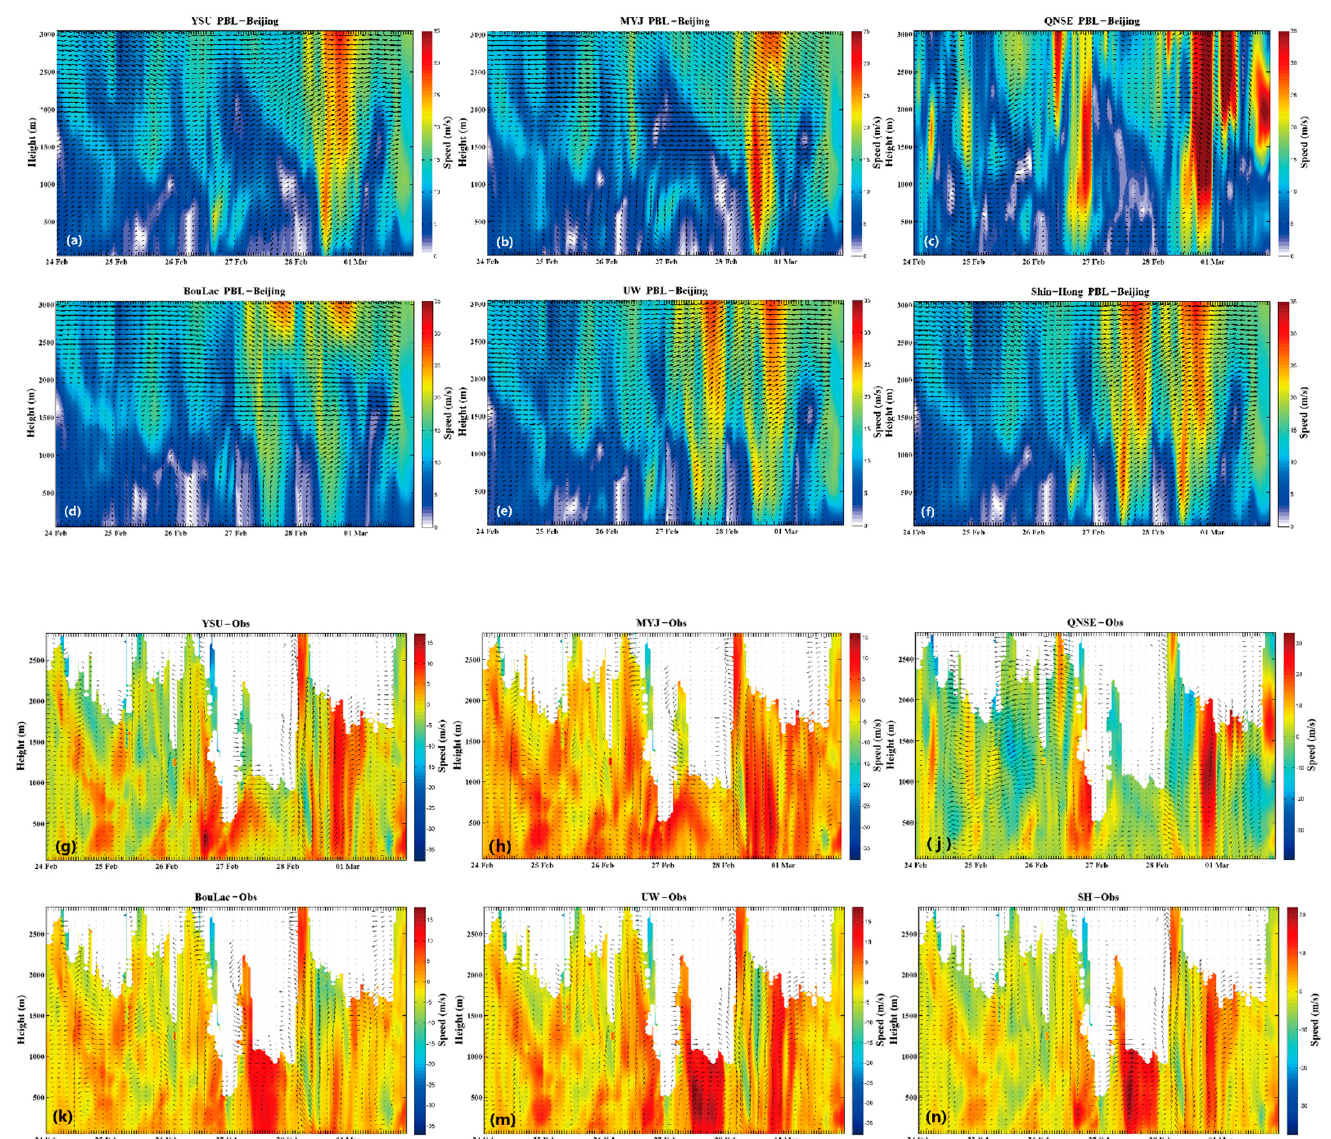
Figure 3. The simulated PM 2.5 concentrations (red line) and the PBL wind structures in Beijing, February 2018.